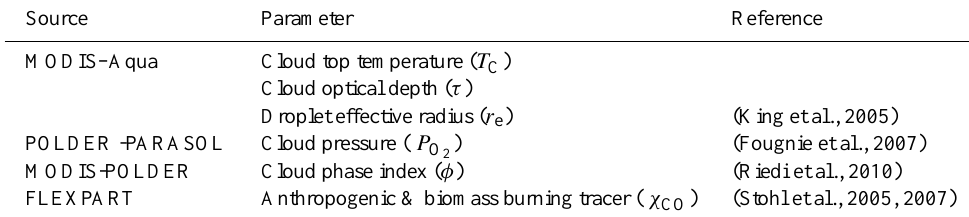
Table 1. Cloud products and pollution tracer used in the